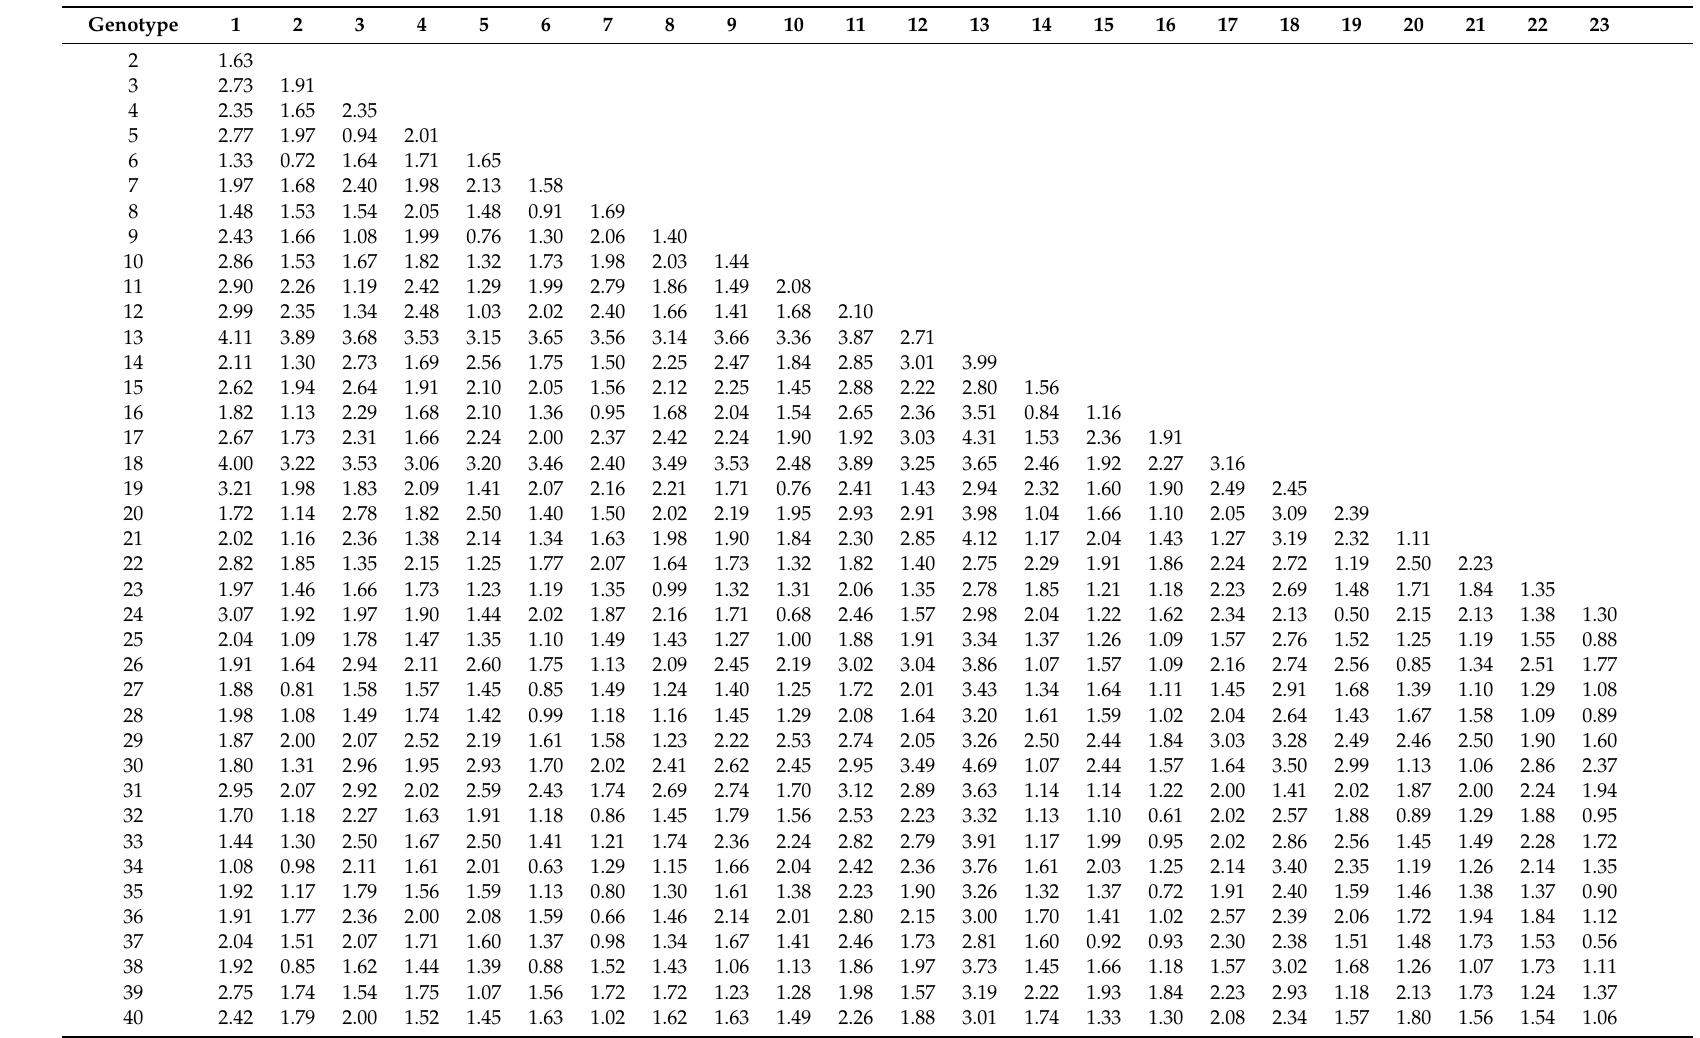
Table A3. Mahalanobis distances between studied Abies genotypes